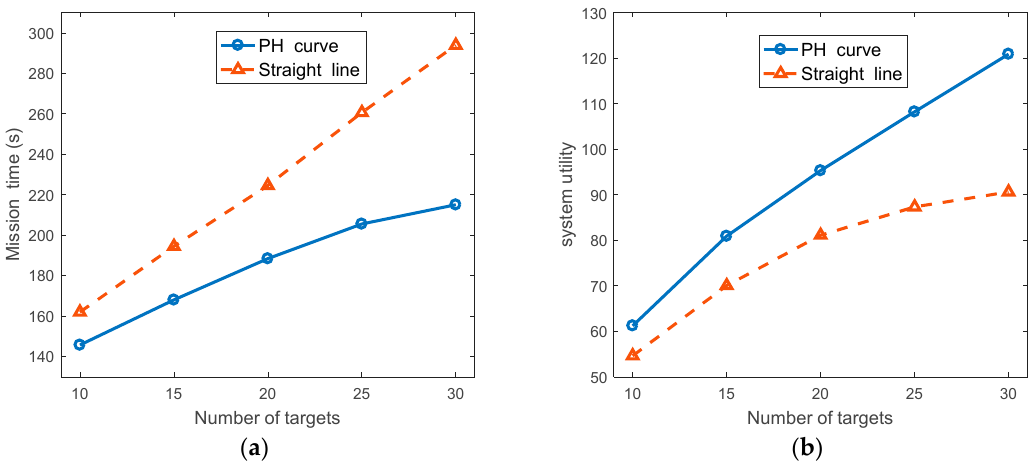
Figure 6. Comparison of the two path estimation methods. ( a ) Average mission completion time; ( b ) average system utility.